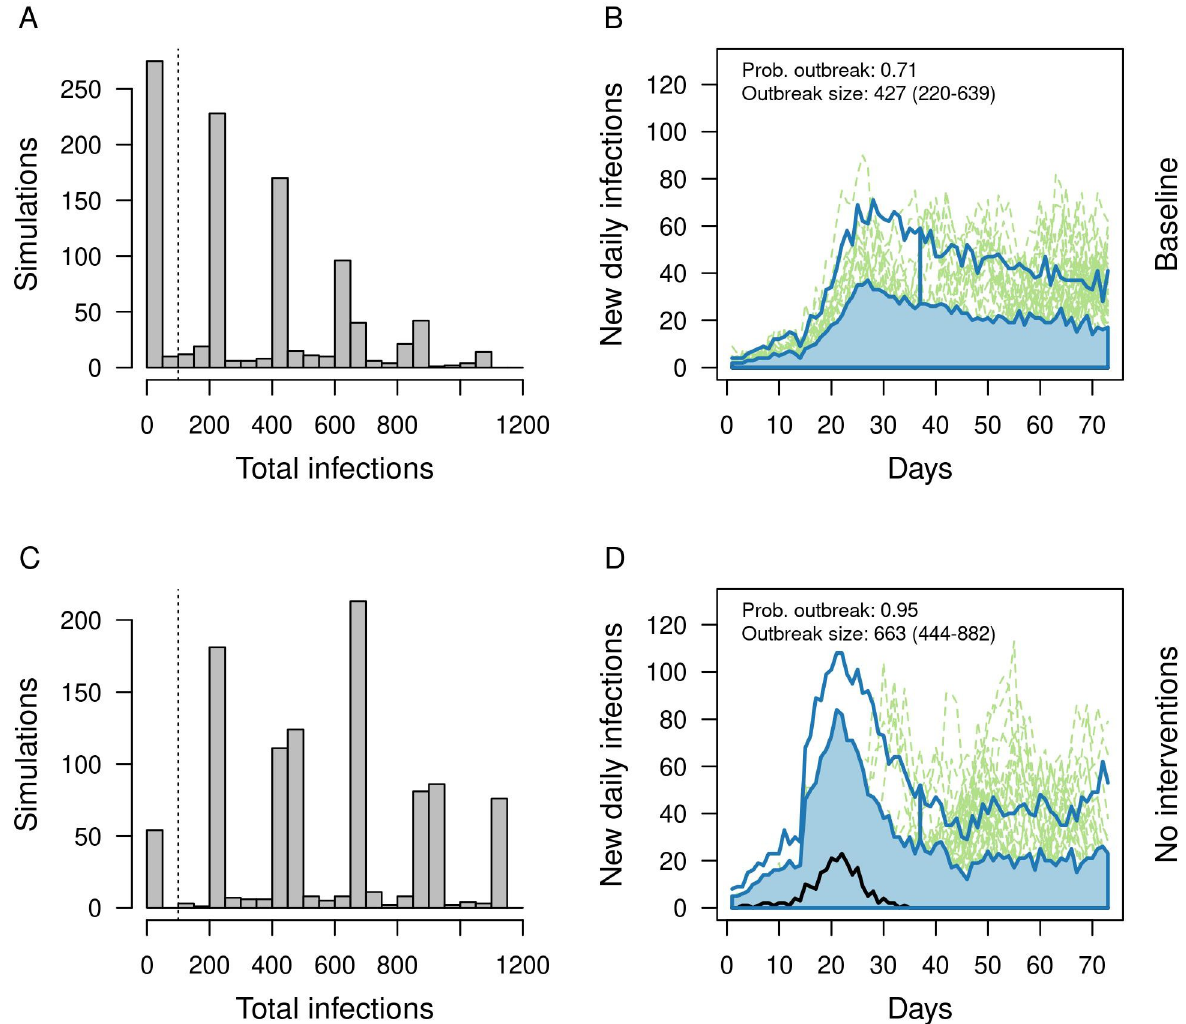
Fig 3. Outbreaks under the baseline scenario (top) and a scenario with no interventions (bottom). Left: Distributions of cumulative infections over the 70-day training period across 1,000 replicate simulations. Right: The functional boxplot shows the median estimate (black line), 50% central region (25–75%) (blue band), 1.5 times central region (blue lines), and outliers defined as lines outside of the 1.5 times the central region (dashed green lines). Based on A, we defined an outbreak as 100 or more total infections (vertical dashed lines in A and C). The probability of an outbreak and the median and 25–75% interval of outbreak sizes are printed in B and